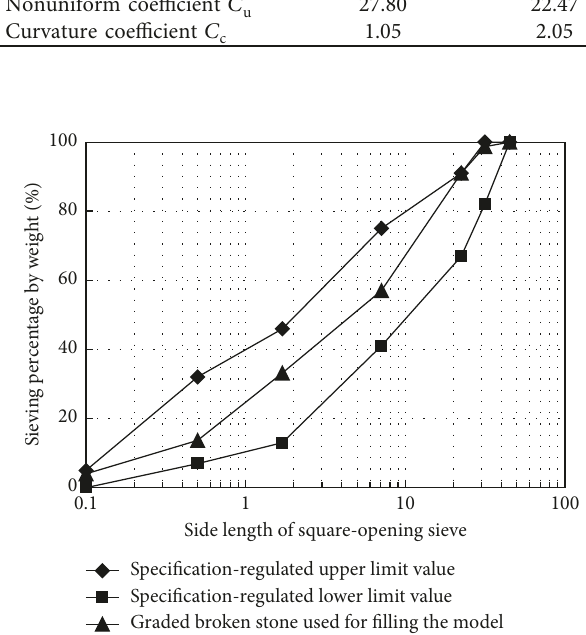
Figure 4: Grain-size distribution curves of the graded crushed